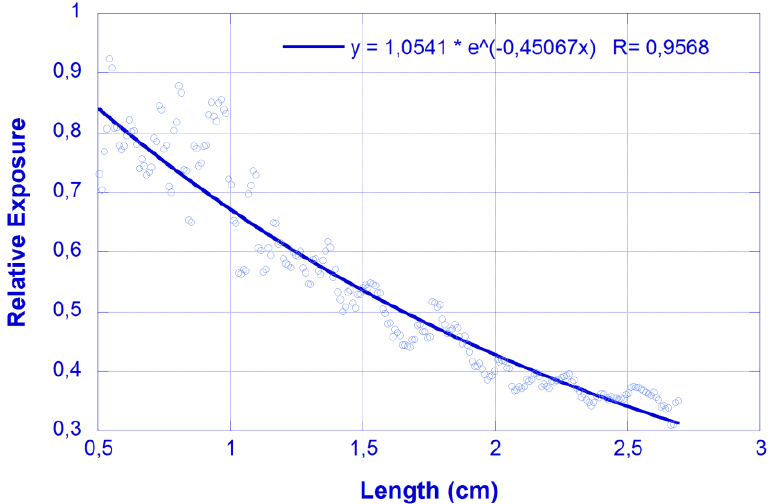
Figure 3. Relative exposure vs. longitudinal coordinate (photographic method). Feeding laser λ = 450 nm. Dots: experimental values; Solid line: fit to exponential decay.